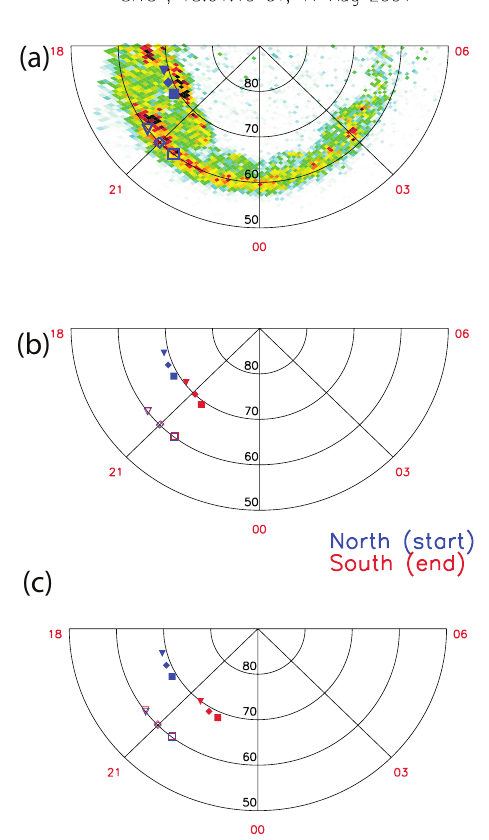
Figure 7. Field line tracing from one hemisphere to the other using the Tsyganenko 2002 model. (a) Blue symbols indicate the starting tracing points in the Northern Hemisphere. Filled and open symbols are used for the poleward and the equatorward edge of the aurora, respectively. In panels (b) and (c) blue (red) symbols mark the foot- print in the Northern (Southern) Hemisphere for tracing from north to south using different input values (see text for explanation). The blue symbols are at the same locations in all panels.